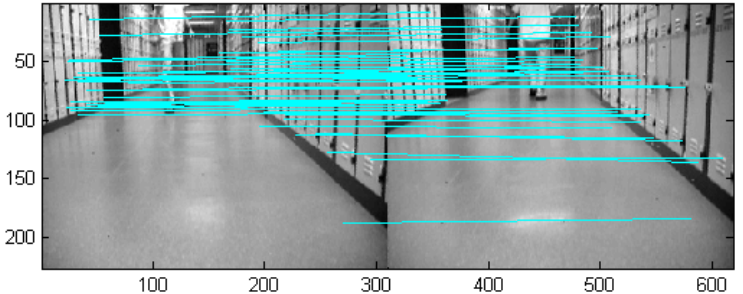
Figure 3. Matched point determined by SIFT